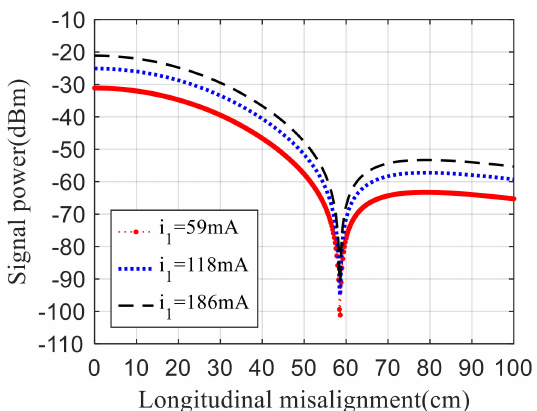
Figure 20. Variation of uplink received signal power with different uplink transmitting current intensity (active balise).